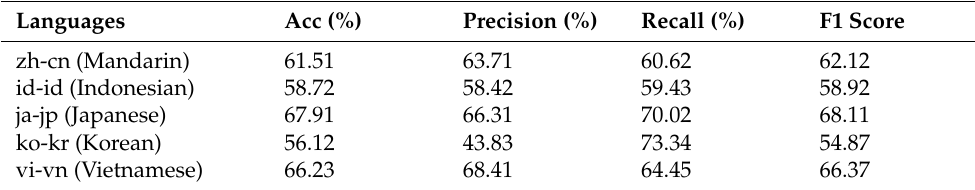
Table 4. Experimental results for multilingual cocktail party data with a 100% overlap rate.